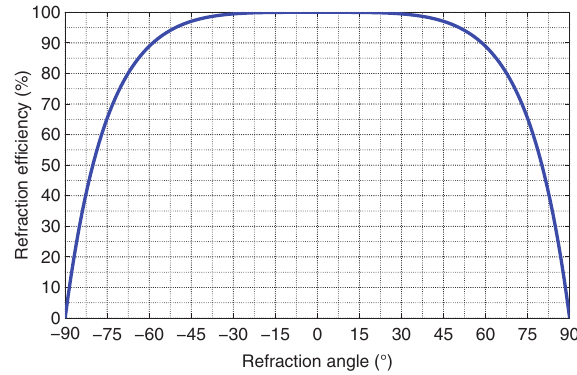
Figure 6: Non-bianisotropic boundary conditions for 0 ° to 71.8 ° TE refraction at 20 GHz. (A) Imaginary and real components of Z . (B) Imaginary and real se components of Y sm